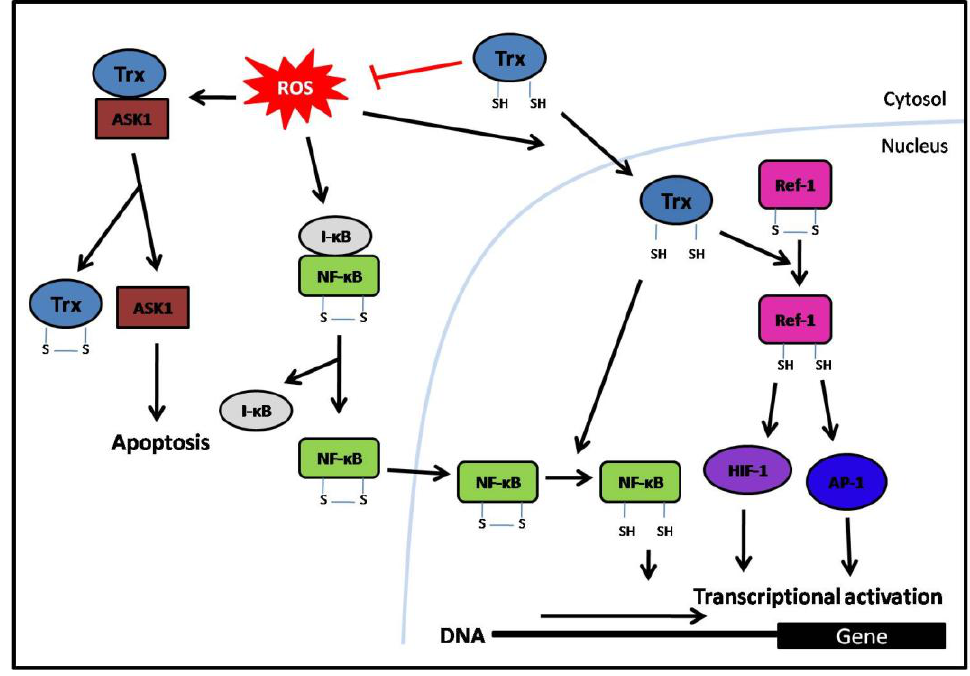
Figure 3. Thioredoxin (Trx) and redox signaling of transcription factors. Trx negatively regulates apoptosis in the cytoplasm via redox regulation of ASK-1 and inhibition of Iκβ degradation by scavenging ROS. Under oxidative conditions, Trx is translocated to the nucleus where it increases the DNA binding activity of NF-κβ via reduction of its cysteine residue. Trx also increases the DNA binding activity of other transcription factors, such as AP-1 and HIF-1, indirectly via the intermediate Ref-1. Red lines indicate an inhibitory effect. S-S = oxidized form. SH = reduced